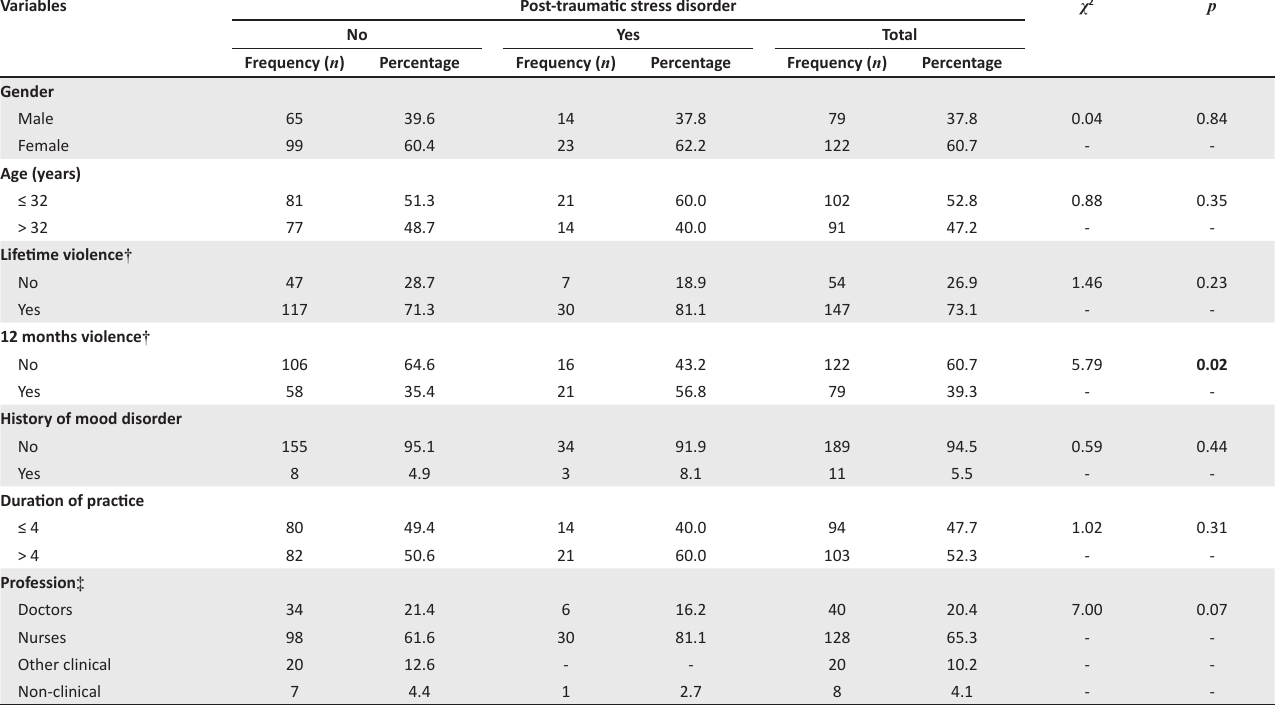
TABLE 2: Association of post-traumatic stress disorder caseness with risk variables.